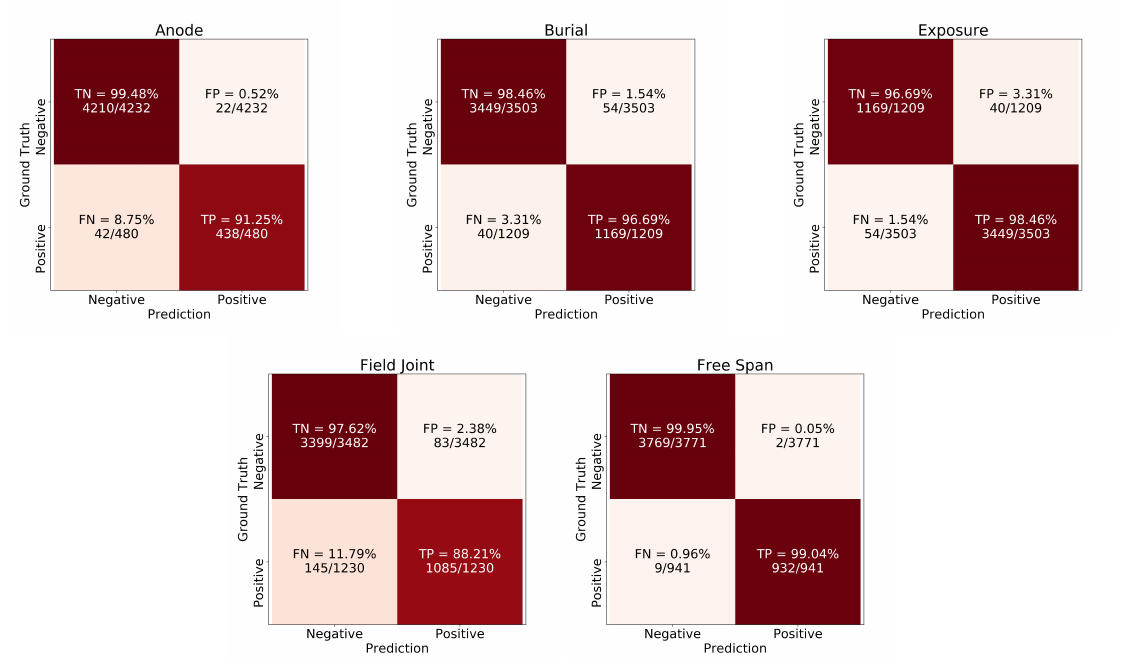
Figure 8. Confusion matrices on the test set for each class; anode, burial, exposure, field joint and free